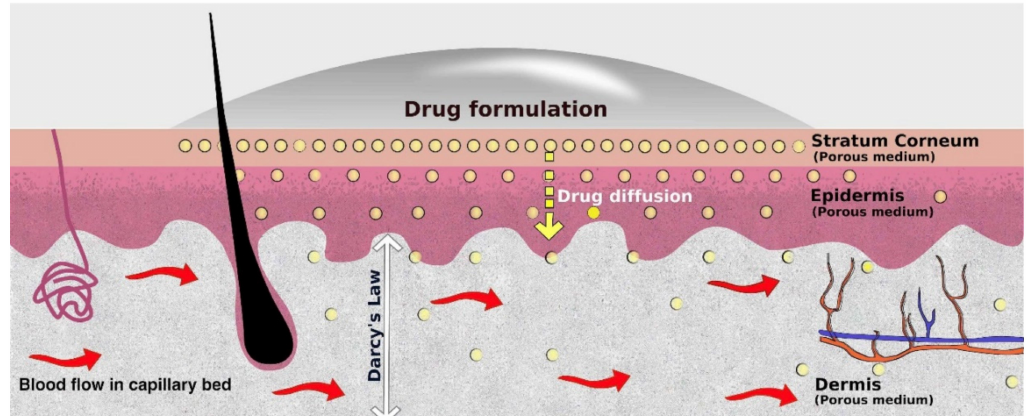
Figure 8. Representation of different layers of the skin along with the diffusion of drugs in the skin. The layers can be considered as a porous medium and the porous medium equations can be written for the mass transfer across the SC, Epidermis, and Dermis. For the blood flow in the tissues, the Darcy model can be